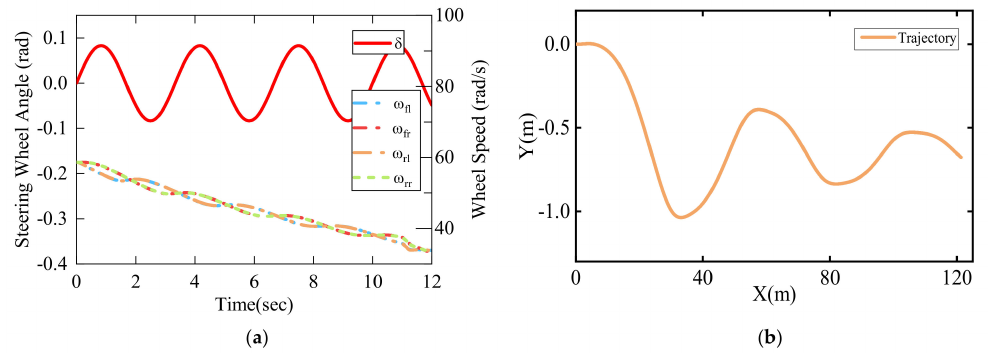
Figure 8. Sinusoidal steering combined with braking conditions: ( a ) observer input, including front wheel angle and four-wheel speed; ( b ) vehicle trajectory.